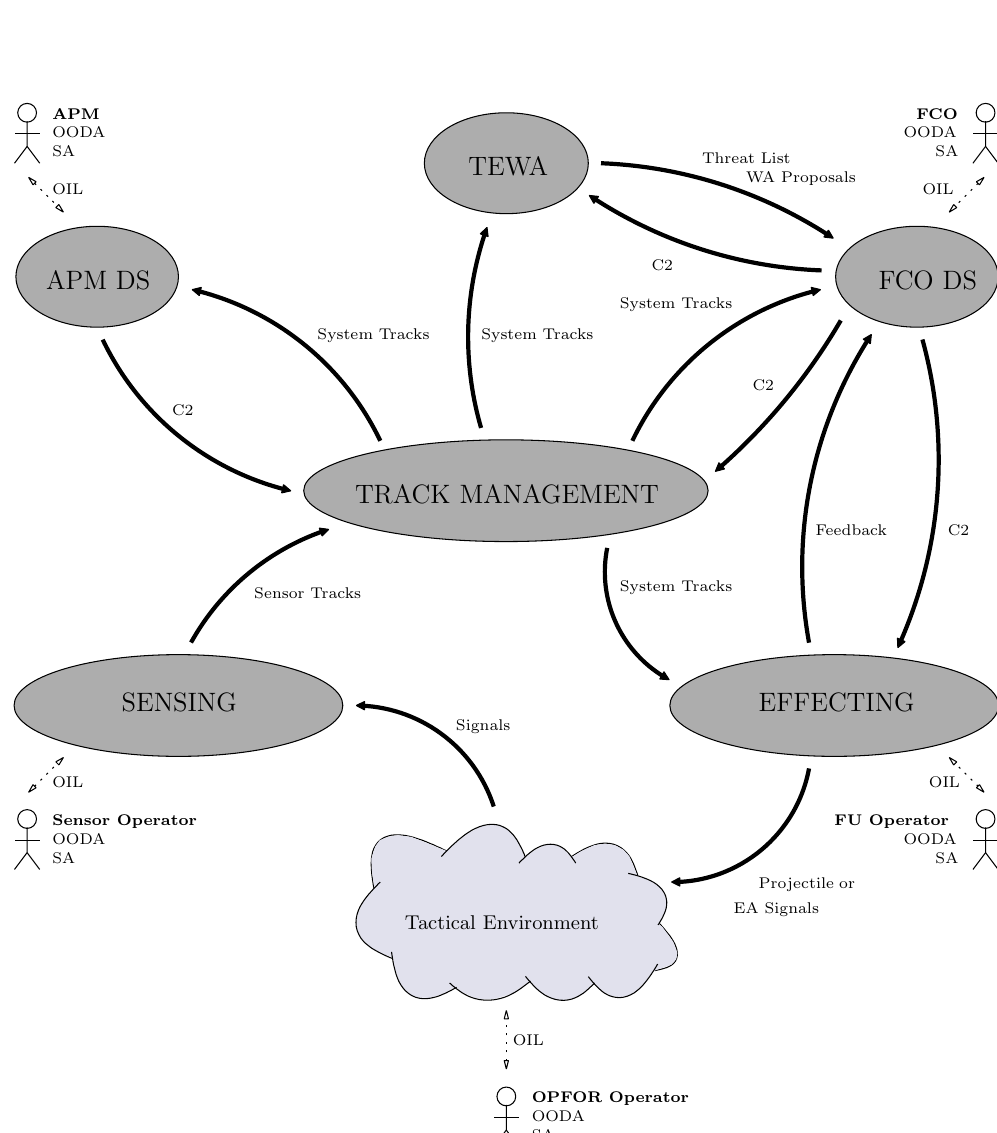
Figure 9: The TEWA and related processes — including Air Picture Manager (APM) Decision Support (DS), Fire Control Operator (FCO) DS, track management, sensing and effecting — involved in a typical engagement of an aerial threat are provided. The various Operators-In-the- Loop (OILs) are also shown, each possessing a certain level of Situation Awareness (SA) and an Observe, Orientate, Decide and Act (OODA) cognitive